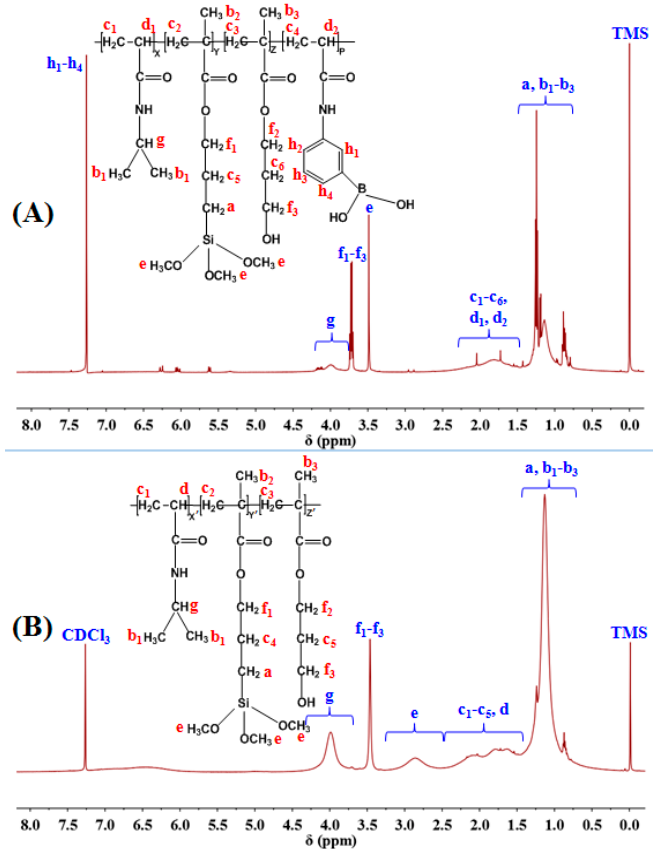
Figure 3. 1 H-NMR spectra of PNAHT ( A ) and PNHT ( B ) copolymers. Table 1. Molecular composition of PNAHT and PNHT copolymers.